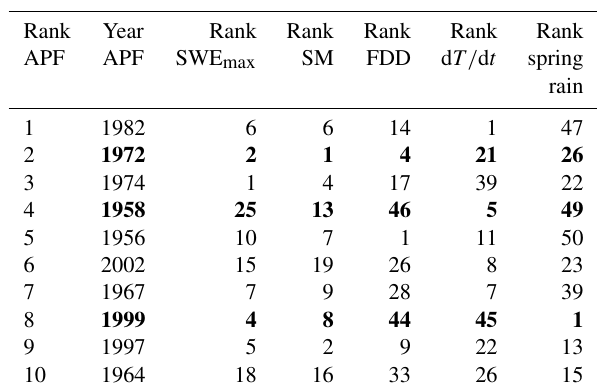
Table 5. Top 10 APF years at Fraser-Hope in the VIC simulation over the period 1955–2004, along with corresponding ranks of other basin-averaged predictors. Years in boldface font are highlighted in Fig.